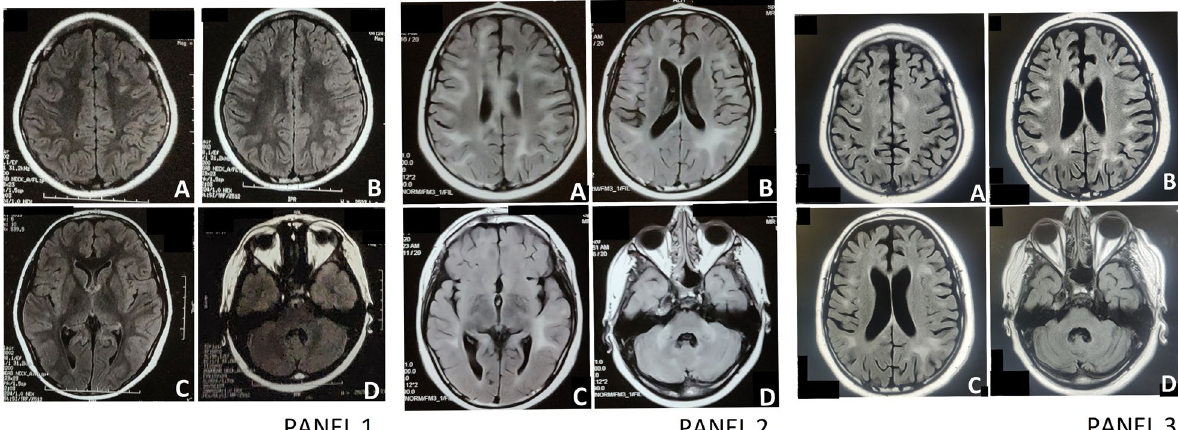
Fig. 1 Panel 1: MRI Brain T2 FLAIR axial sections showing few indistinct scattered foci of hyperintensities in the white matters of superficial parietal lobe ( A , B ) without any other abnormalities ( C , D ). Panel 2: MRI Brain T2 FLAIR axial sections showing hyperintensities extensive superficial and deep white matter in both the cerebral hemisphere ( A – C ) and middle cerebellar peduncle and cerebellum ( D ). Panel 3: MRI Brain T2 FLAIR axial sections showing marked decrease in areas of hyperintensities following Rituximab therapy ( A – D